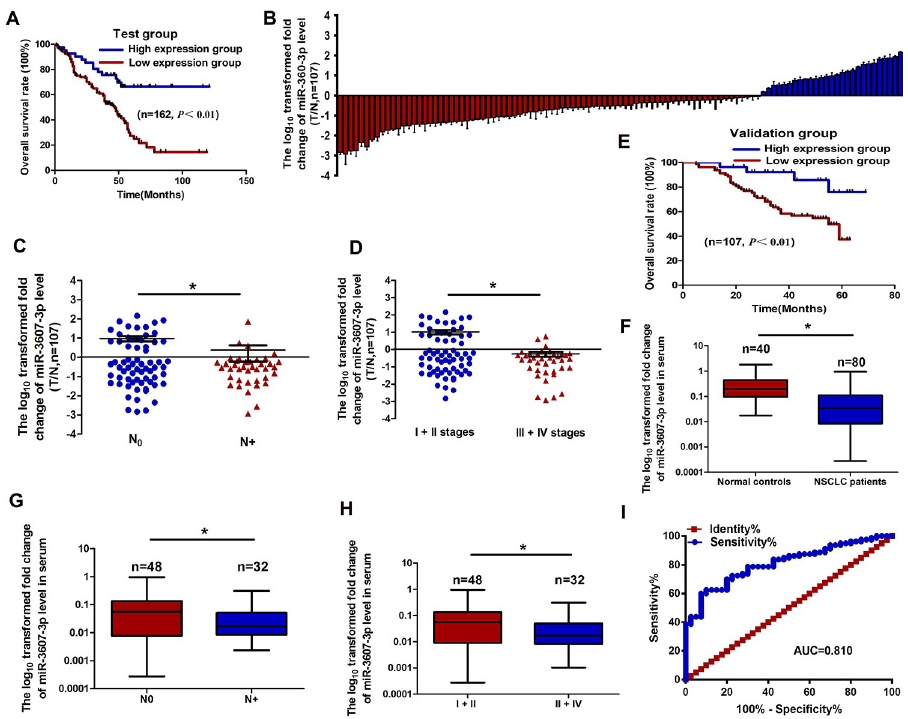
Fig 2. The relationship between miR-3607-3p expression levels in NSCLC tissues or serum and clinical significances. (A) Kaplan-Meier overall survival curves according to high and low miR-3607-3p expression in 162 patients with NSCLC. (B) Quantitation of miR-3607-3p was performed using qRT-PCR in 107 NSCLC (T) and adjacent normal (N) tissues. The fold changes were calculated by relative quantification (2 - Δ Ct , U6 as the internal control). (C-D) miR-3607-3p expression was detected in primary tumor tissues and the patients were grouped according to lymph node metastasis status (C) or clinical stages (D). (E) Kaplan-Meier curves depicting overall survival according to the expression of miR-3607-3p from the validation set. (F) The expression levels of serum miR-3607-3p in 80 NSCLC patients and 40 healthy controls were measured by qRT-PCR and normalized to U6. (G-H) Serum miR- 3607-3p expression was low in patients with NSCLC, indicated by lymph node metastasis (G) and different clinical stages (H). (I) Receiver operating characteristic (ROC) curve analysis of the miR-3607-3p assay ratio for detecting NSCLC patients. � , P < 0.05.